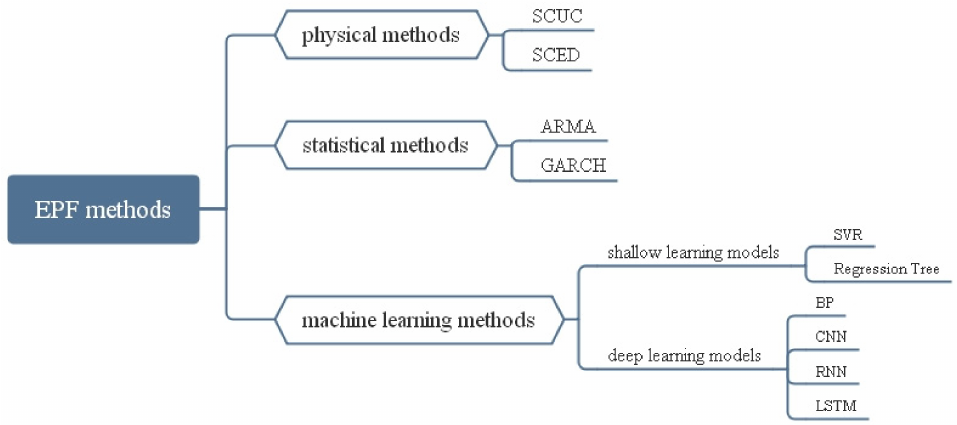
Figure 1. Overview of current research methods for EPF